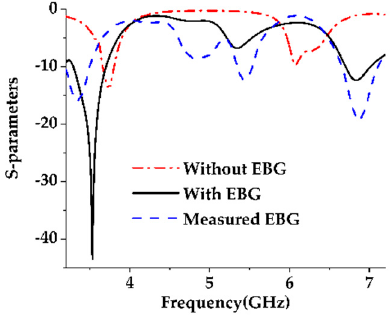
Figure 15. Comparison of the S-parameters of the EBG and Non-EBG configurations.